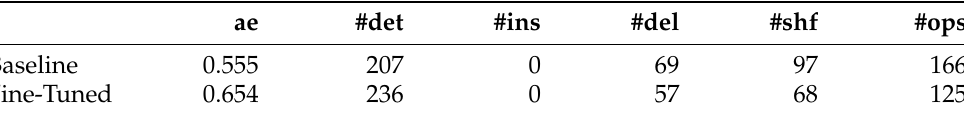
Figure 9. Network outputs for the baseline and fine-tuning approaches on Choros № 1 (zoomed over the initial 40s). Finetune region 0–15s (blue) and the test region starting at 15s (green). The dark blue solid line indicates the network prediction. The vertical grey dotted lines show the ground truth annotations. The vertical light blue solid lines show the correct beat detections. The incorrect beat outputs are noted with the required operation colour (delete—orange, shift—pink, insert—green) to correct the annotation. Table 5. Annotation efficiency (ae), correct detections (#det) and insertions (#ins), deletions (#del), shifts (#shf) and total edit operations (#ops) for Choros № 1